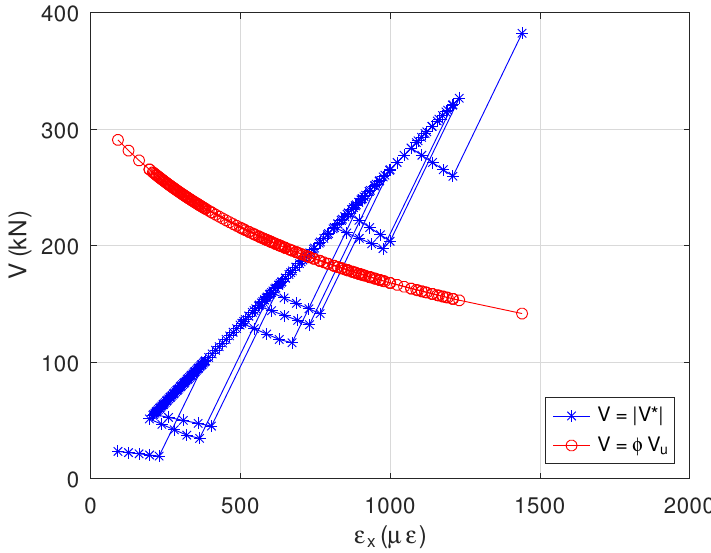
Figure 4. V ∗ versus (cid:101) x for x veh = 0.0 to 20.8 m. A plot of V ∗ against M ∗ is shown in Figure 5. This plot shows the discontinuities in shear when an axle crosses the section owing to the assumption of modelling the axles as concentrated axle loads. This assumption is commonly used with a line beam model. In reality, each wheel occupies a finite area on the bridge deck. The shear increases abruptly when an axle crosses the section. Thus there is no clear intersection between the shear V ∗ with its corresponding reduced capacity φ V u line. Even if the axles are modelled using a uniform distributed load, the increase in shear will still be abrupt since the length of the wheel patch in the direction of travel is only 0.2 m.